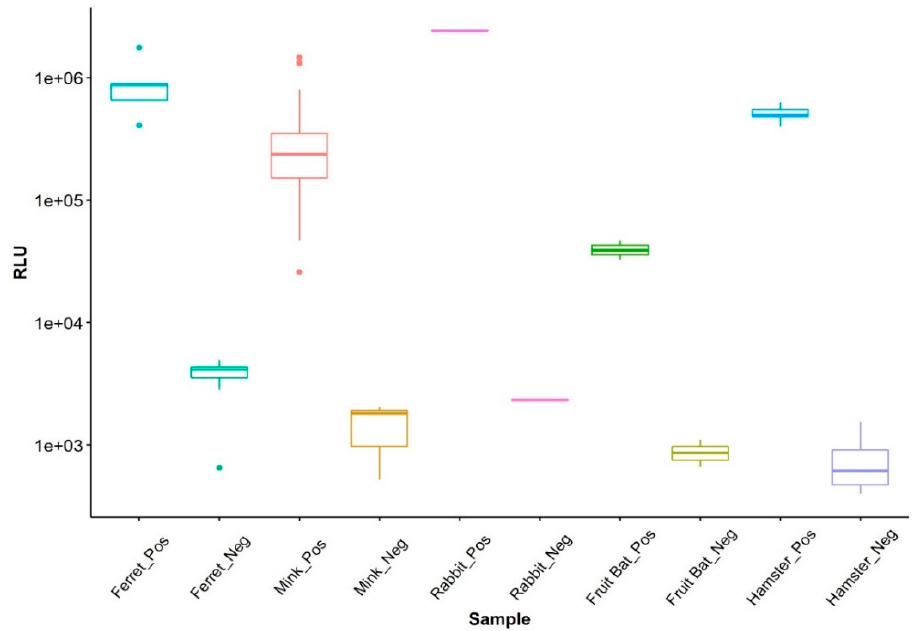
Figure 1. Boxplot showing the differences between the LIPS-S negative and positive samples and the relative similar levels of antibodies found in the negative samples across species. Jpn.